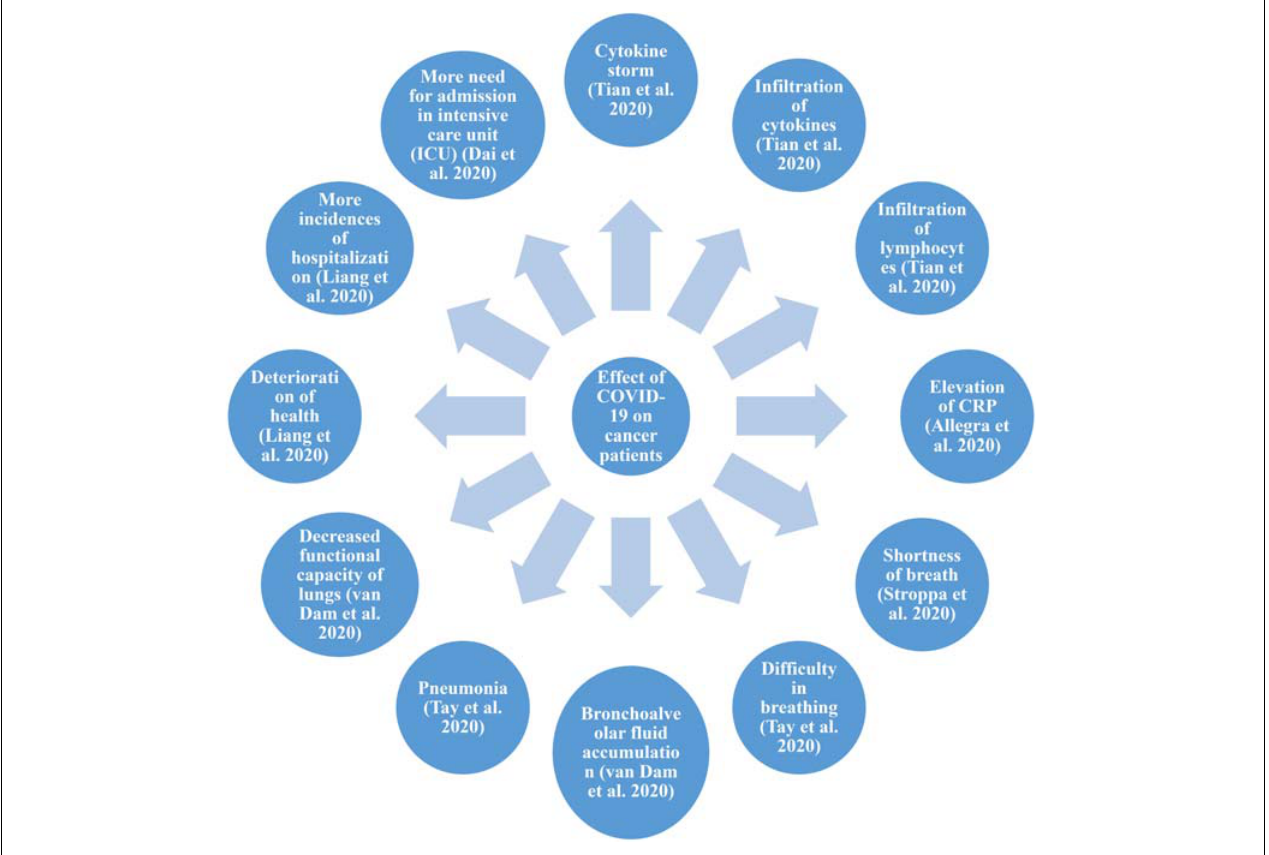
FIGURE 3 | Effect of COVID-19 on cancer patients. Effect of COVID-19 on cancer patients with respect to inflammation, and changes to the respiratory system, health, and quality of